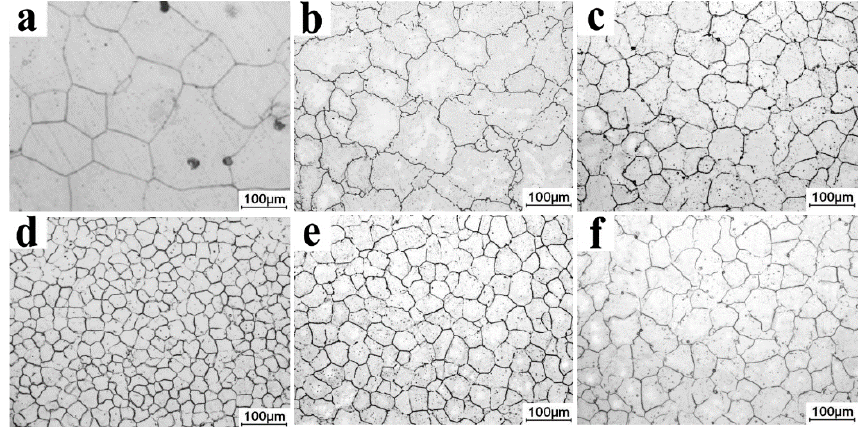
Figure 11. OM micrographs of as-solution Grp/AZ91D composites with different holding times: ( a ) 0 min, ( b ) 5 min, ( c ) 10 min, ( d ) 15 min, ( e ) 20 min, and ( f ) 30 min.